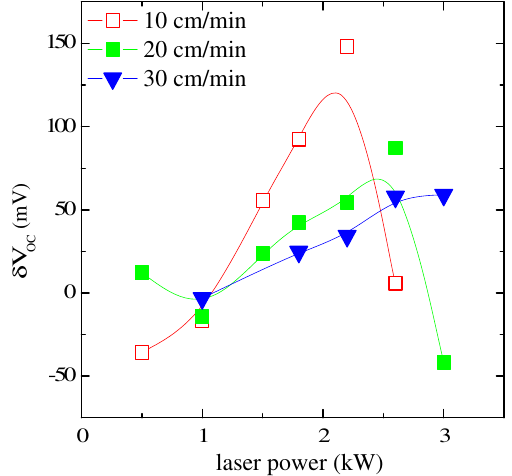
Fig. 3. Variation of open circuit voltage of laser annealed poly- silicon structures as a function of laser power and at different scan